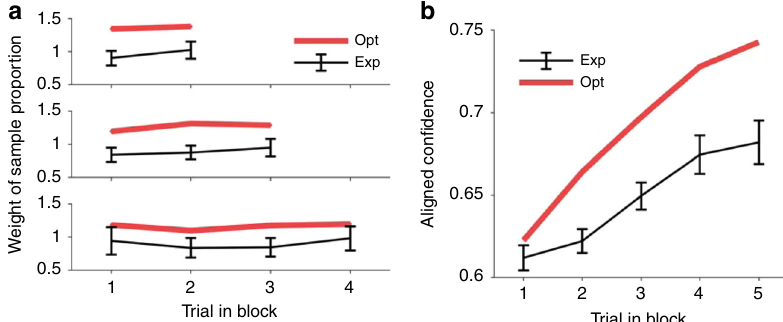
Fig. 7 Behavior re fl ects hierarchical evidence integration across trials. a On average across blocks, all previous trials provide the same information about the block tendency irrespective of their temporal distance to the current trial. From top to bottom, trials number 3 – 5 of each block are predicted from the indicated previous trials (sample proportion). Participants show a balanced weighting despite smaller weights compared to the ideal observer model (red). b Participants accumulate evidence about the block tendency in a gradual fashion. Aligned con fi dence increases over trials within a block despite a smaller effect compared to the optimal model (red). Error bars indicate SEM across participants.